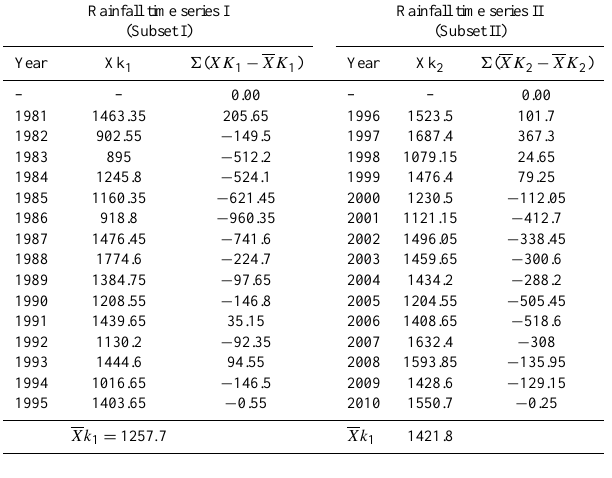
Table 2. Cumulative Departures from the mean of the two time series.